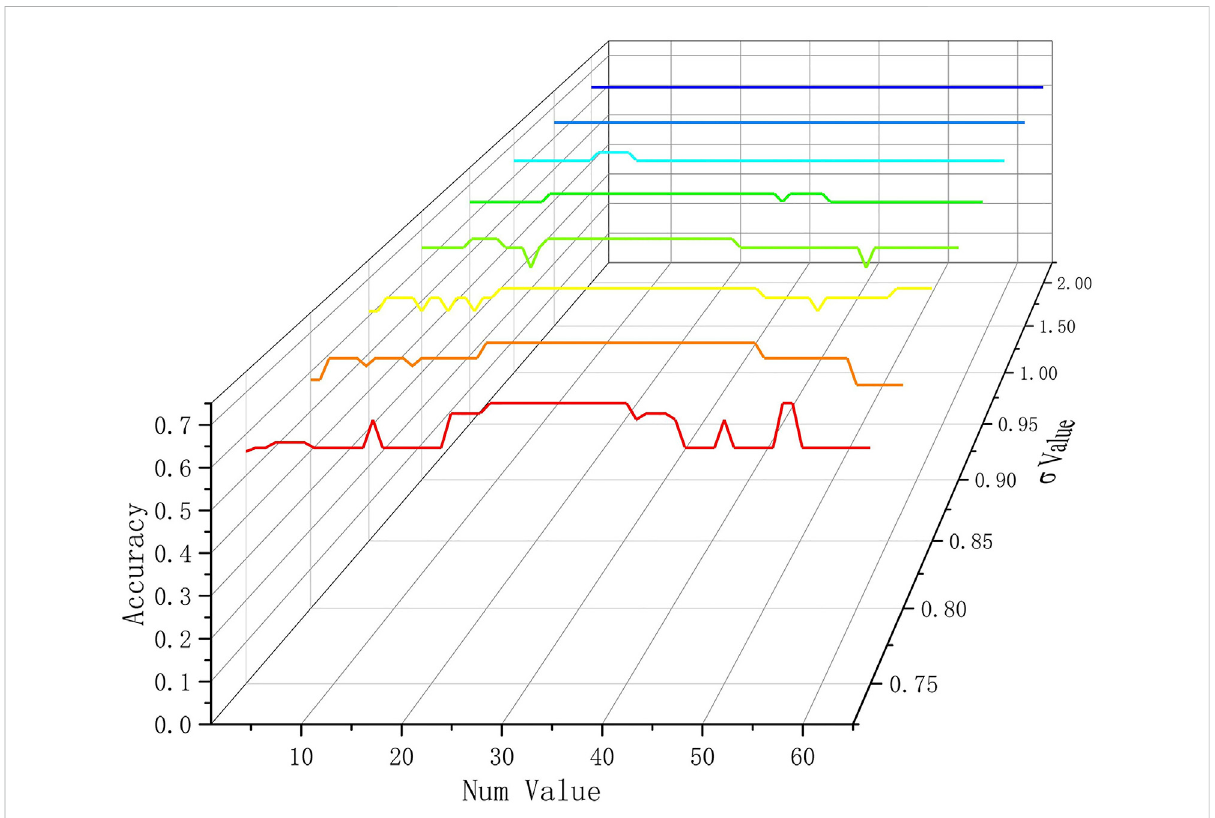
FIGURE 5 Accuracy under different Num values and σ